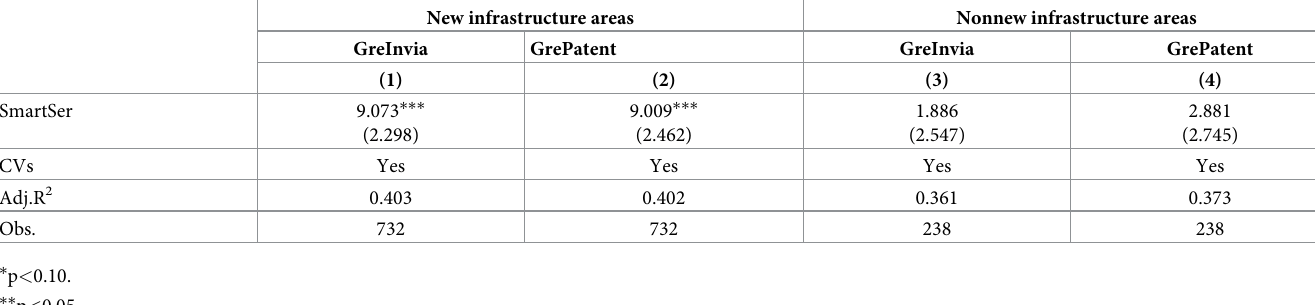
Table 9. Results of regional new infrastructure